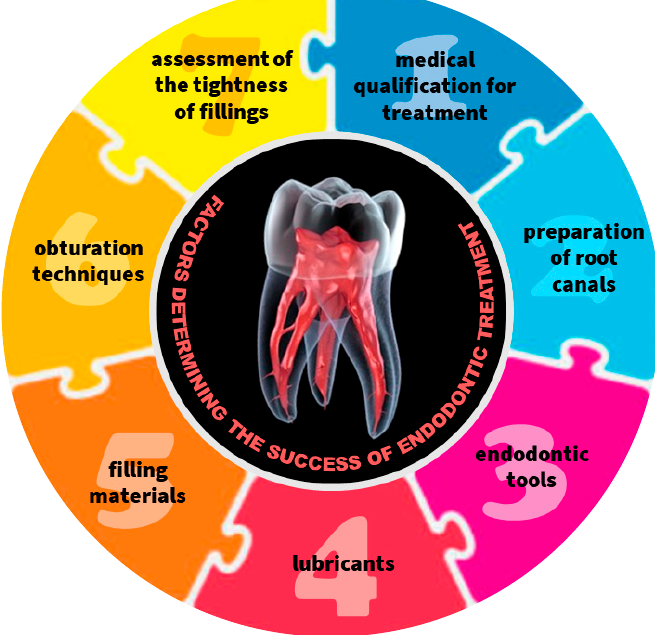
Figure 3. Scheme of the factors determining the success of endodontic treatment.